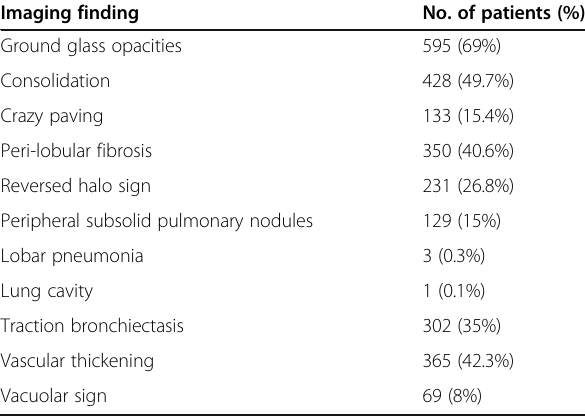
Table 2 Main CT imaging findings in COVID-19 pneumonia Imaging